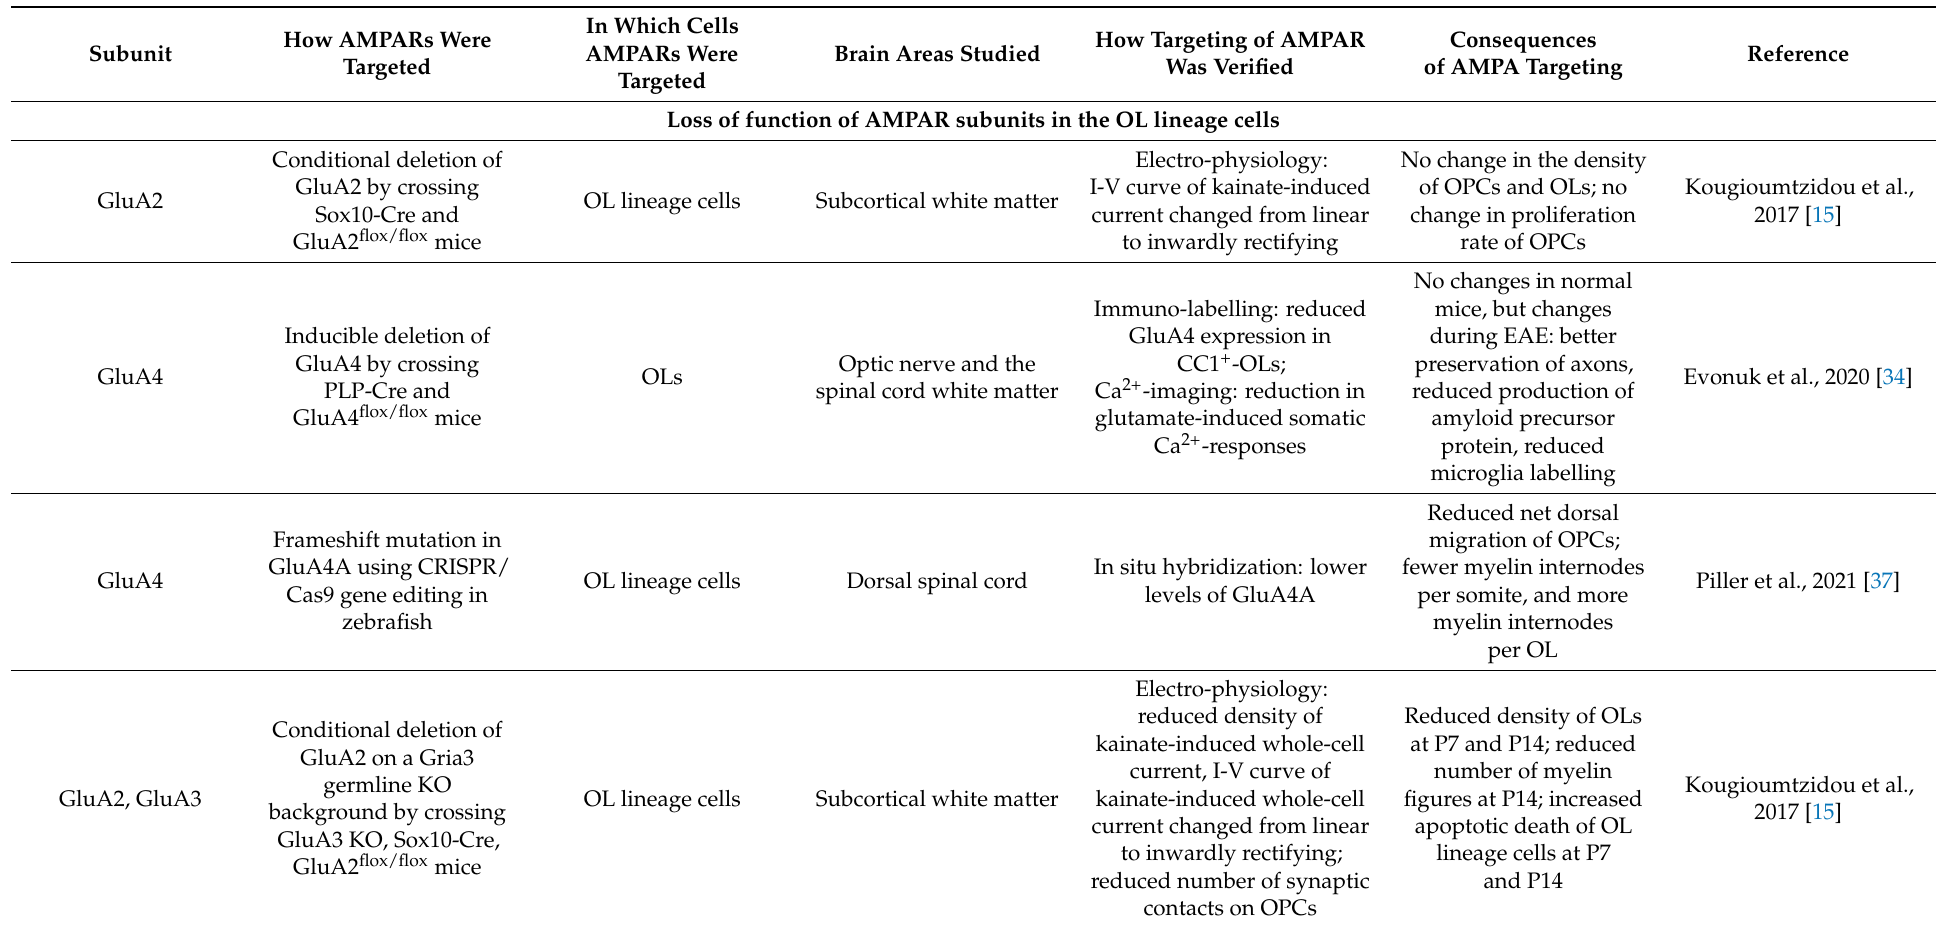
Table 1. Summary of the studies addressing the functional role of AMPAR subunits in the oligodendrocyte lineage cells in